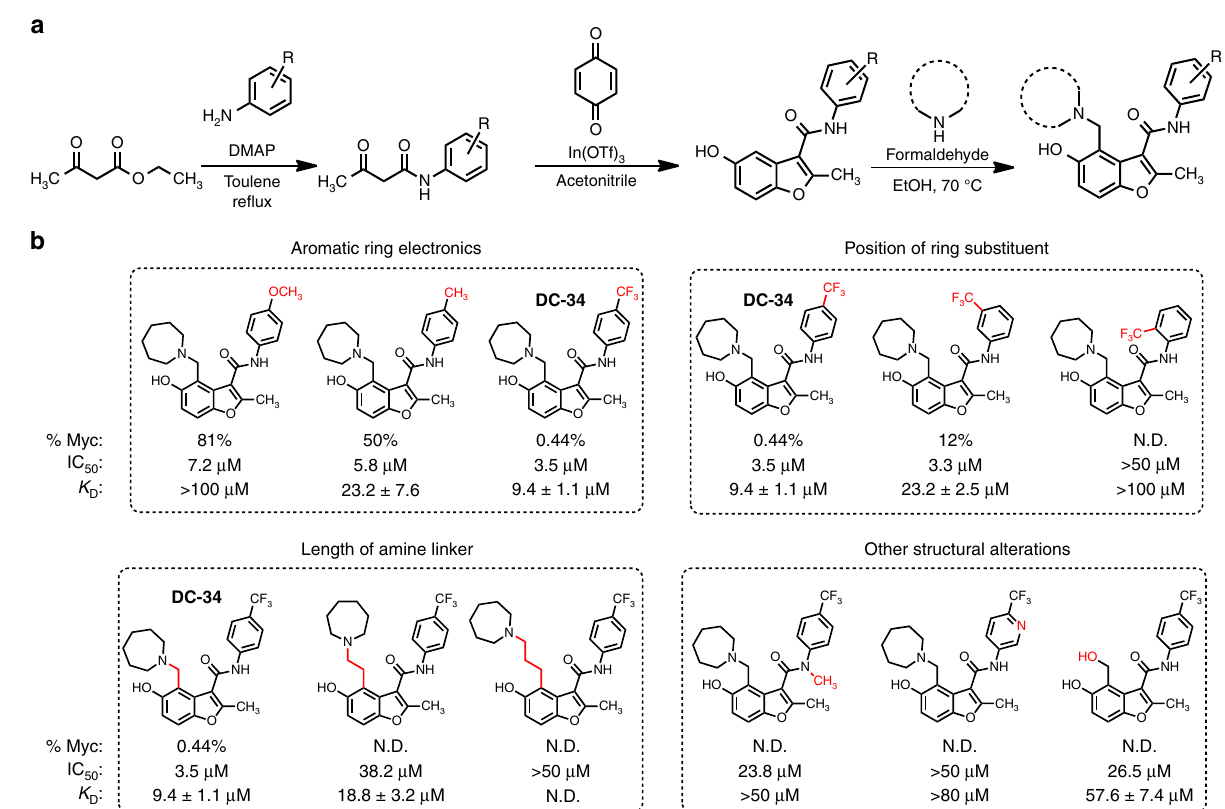
Fig. 1 Structure – activity relationship of DC-34. a Synthesis scheme of MYC G4-binding scaffold. b Table of selected analogs, with the parent compound on the left. %Myc indicates to the percent of MYC protein expressed at a 10 µ M dose in L363 MM cells, IC 50 is the half maximum concentration for cytotoxicity in L363 MM cells at 48 h, and K D determined by a fl uorescence intensity assay. N. D. indicates that value was not